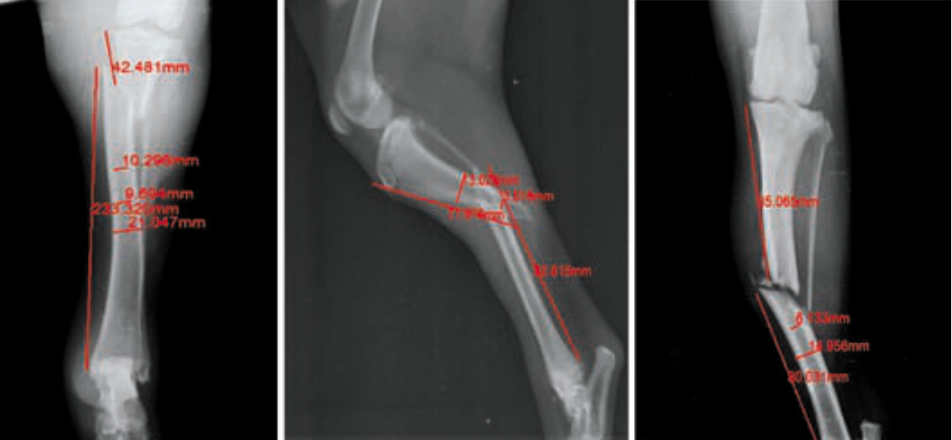
Fig. 1. Radiographs showing diameter of isthmus and diameter of bone, length of proximal and distal fragments of fracture